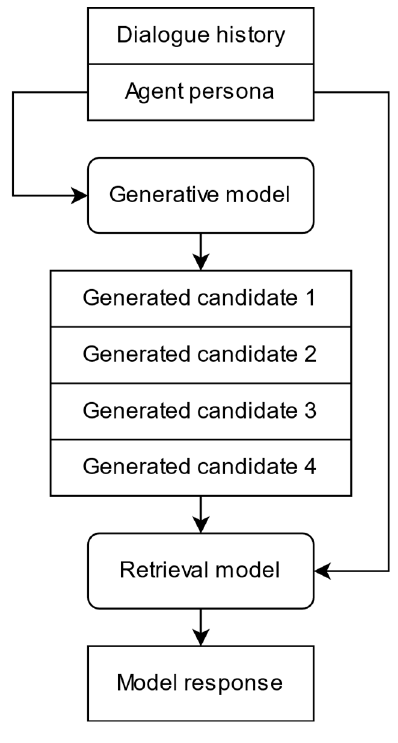
Figure 4. Generate and Retrieve hybrid